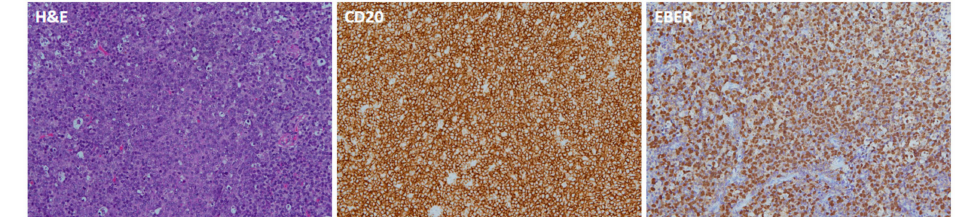
Figure 4. Pathologic images of NP-DLBCL. The hematoxylin and eosin (H&E)-stained slide shows di ff use proliferation of large atypical lymphoid cells. The neoplastic cells are positive for CD20 and